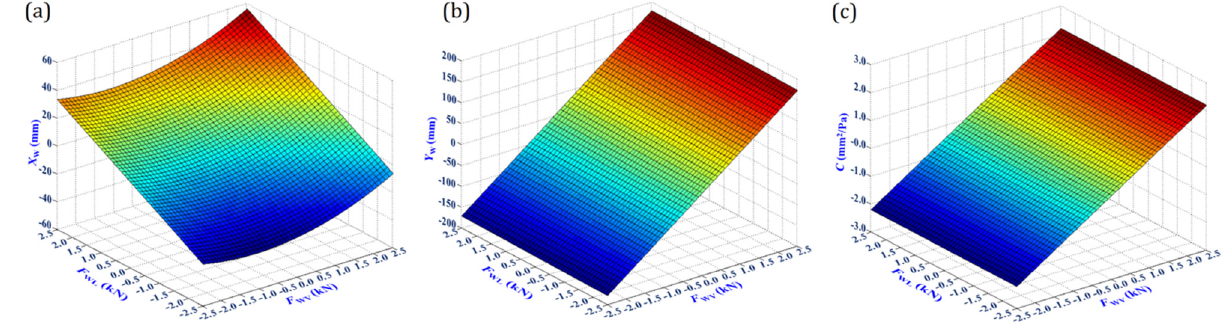
Figure 11: 3D plot under wind loading limits. ( a ) Plot of lateral offset X W ; ( b ) plot of vertical offset Y W ; ( c ) plot of equation component C